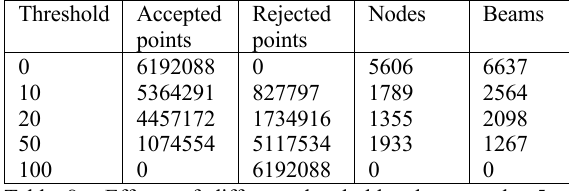
Table 8a. Effects of different threshold values on the 5 cm